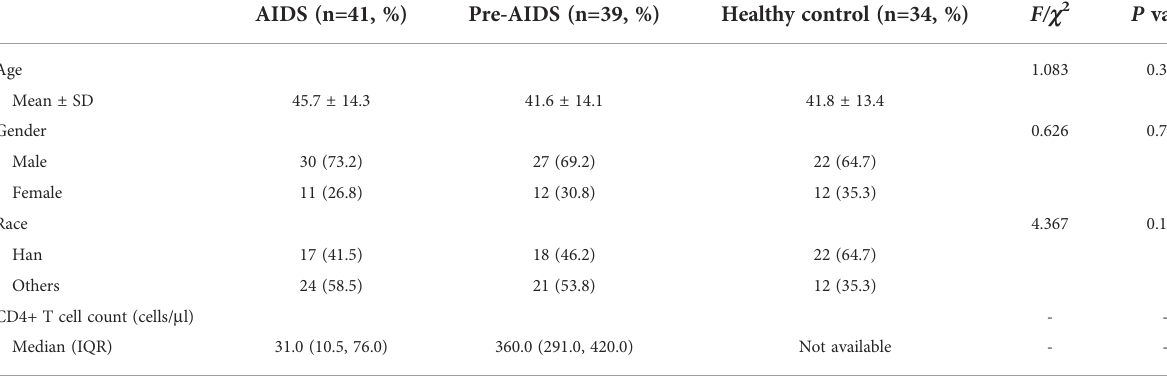
TABLE 1 Baseline characteristics and clinical parameters of study